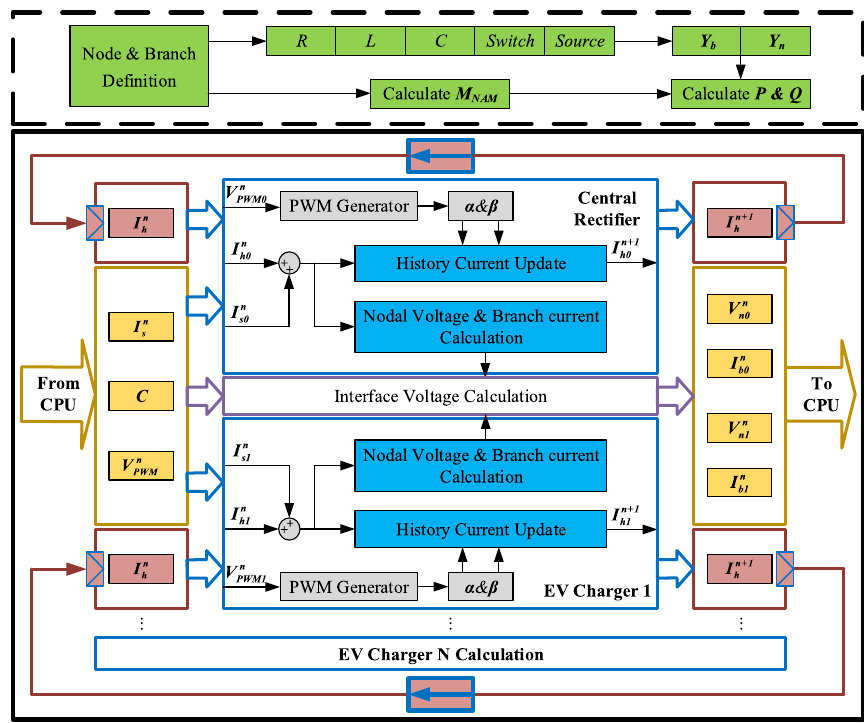
Fig. 5 The simulation loop of the EV charging